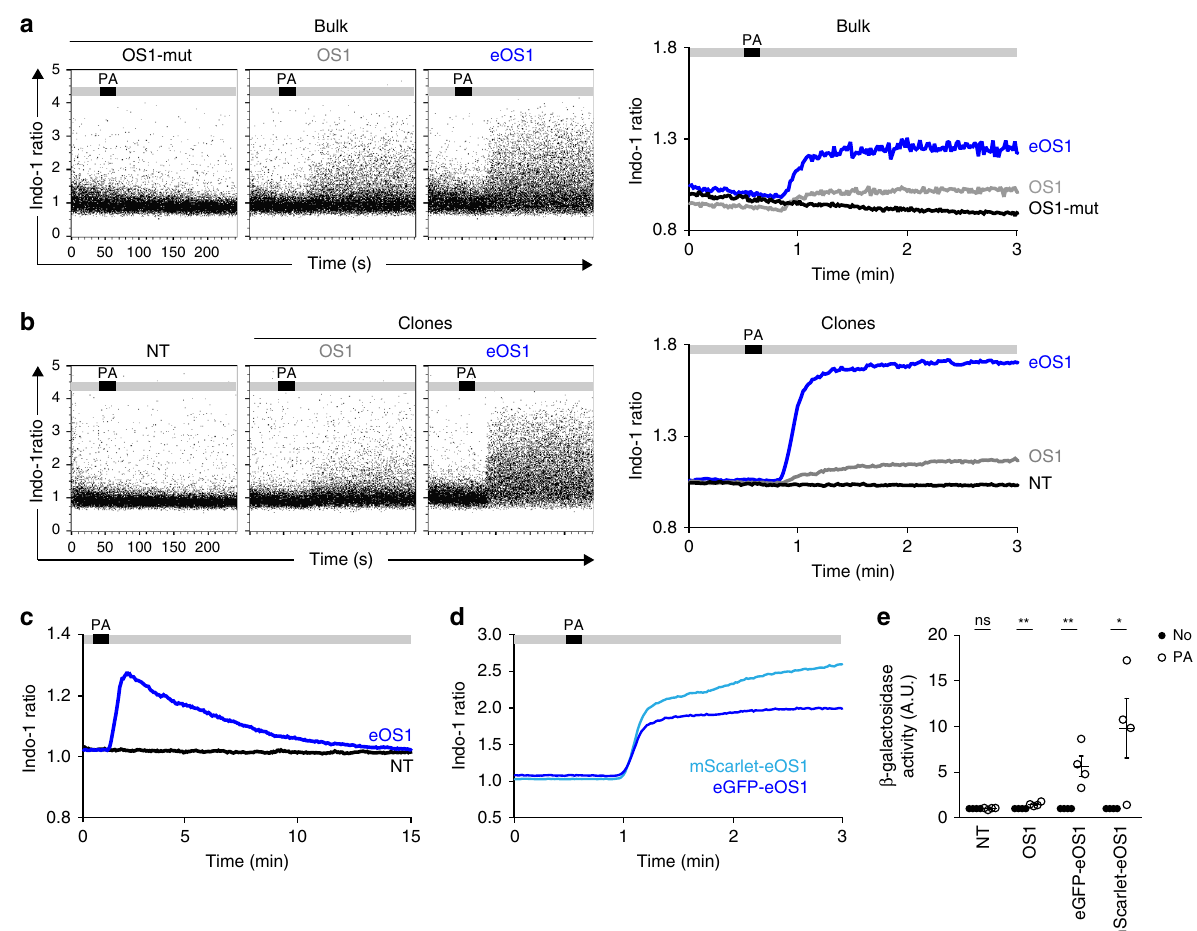
Fig. 1 eOS1, a calcium actuator with enhanced sensitivity. a – d B3Z T cell hybridomas were transduced with the original OptoSTIM1 (OS1) actuator, a mutated version unable to aggregate (OS1-mut) or a mutated version with enhanced Cry2 aggregation potential (eOS1) and loaded with the Indo-1 calcium indicator. Cells were subjected to time-resolved fl ow cytometry and illuminated with an external LED (470 nm) during the acquisition at the indicated time points. Calcium responses shown as dot plots (left) and averaged kinetic curves (right) of bulk B3Z cells a or individual clones b transduced with the indicated actuators. PA indicates the timing of photoactivation during the experiment. Representative of two to four experiments. c eOS1 light-triggered calcium responses typically last 10 min. Time-resolved fl ow cytometry was performed for up to 20 min to assess the duration of calcium